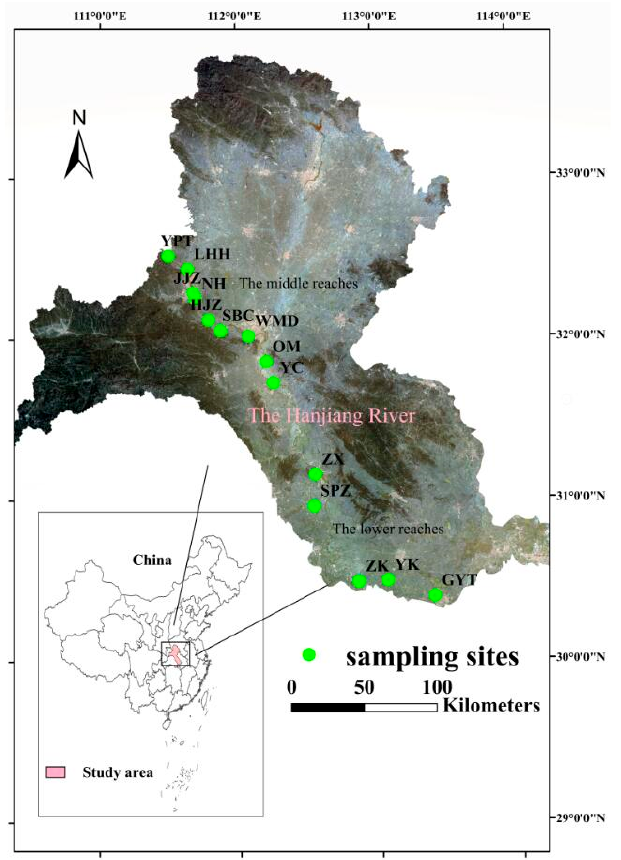
Figure 6. Sampling site locations in the MLHR. The sampling sites were named after the abbreviation of the local place names: YPT, Yangpitan (B); LHH, Lihuahu (B); JJZ, Jiangjiazhou (I); NH, Nanhu (I); HJZ, Hujiazhou (B); SBC, Shanbiancun (I); WMD, Wumingdao (I); OM, Oumiao (I); YC, Yicheng (B); ZX, Zhongxiang (I); SPZ, Shipaizhen (I); ZK, Zekou (B); YK, Yuekou (B); GYT, Guanyintang (B). B in parentheses indicates a beach location and I in parentheses indicates a central island.